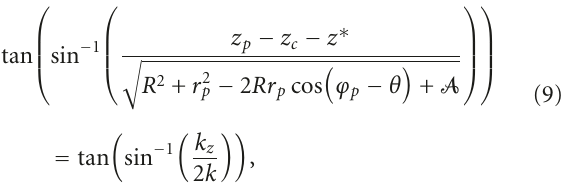
Figure 7: Experiment 1 reconstructed 3D image: (a) ( x , z ) plane view, and (b) ( y , z ) plane